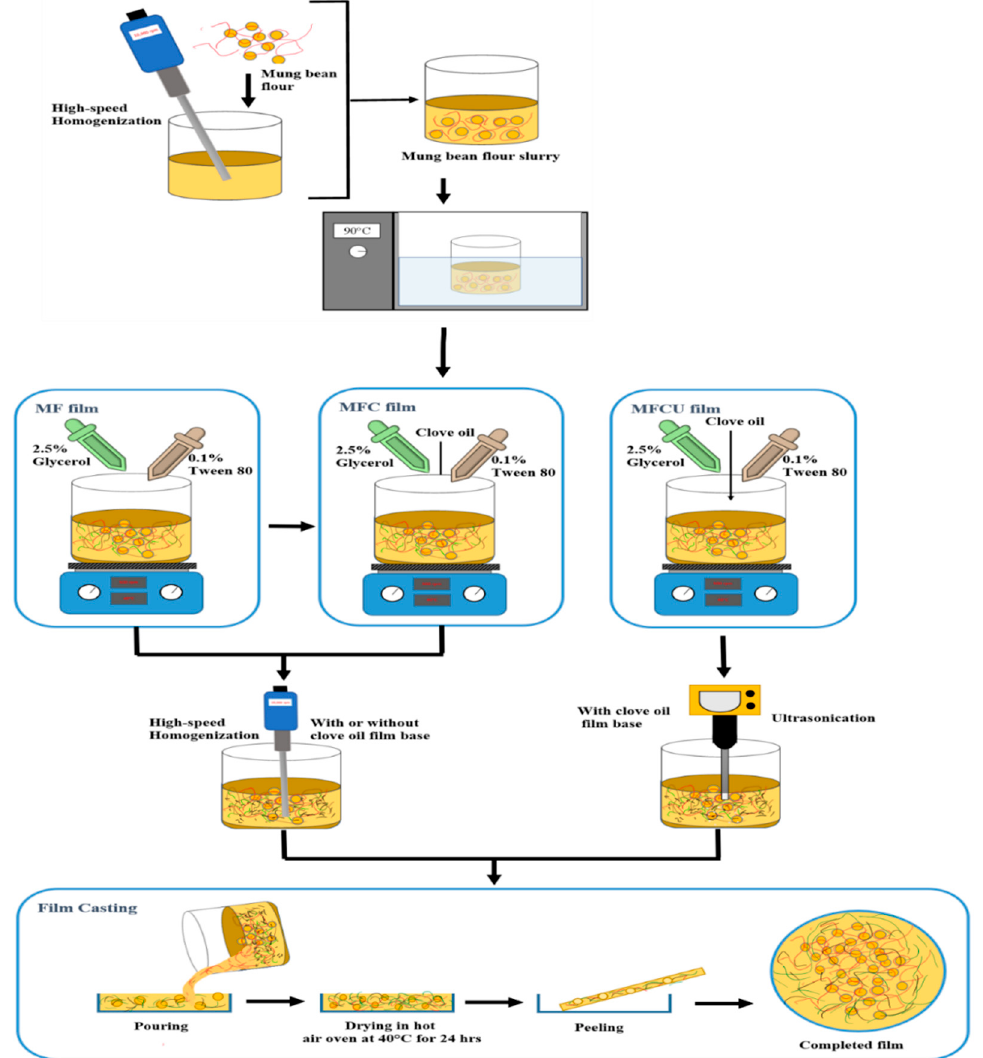
Figure 1. Schematic representation of mung bean flour film formation and its variations. Note MF represents mung bean flour films; MFC represents mung bean flour film incorporated with clove oil; MFCU represents the mung bean flour film incorporated with clove oil and processed with son- ication